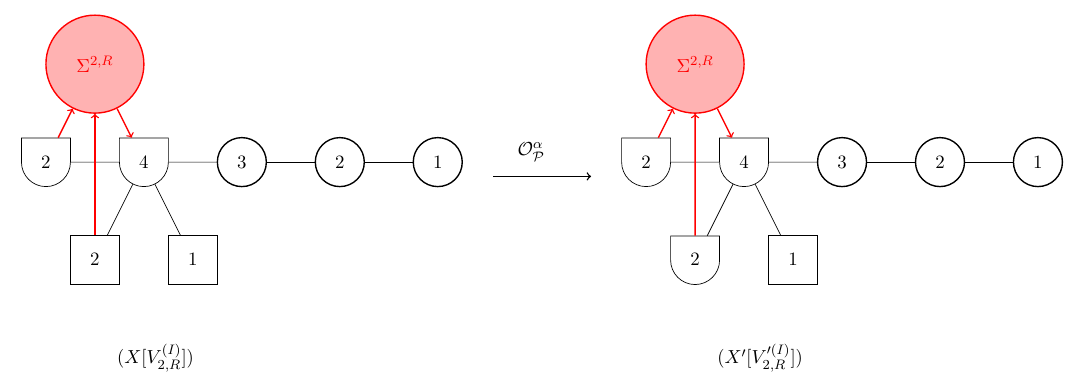
Figure 66 . Construction of a vortex defect in a D-type quiver gauge theory by an S -type